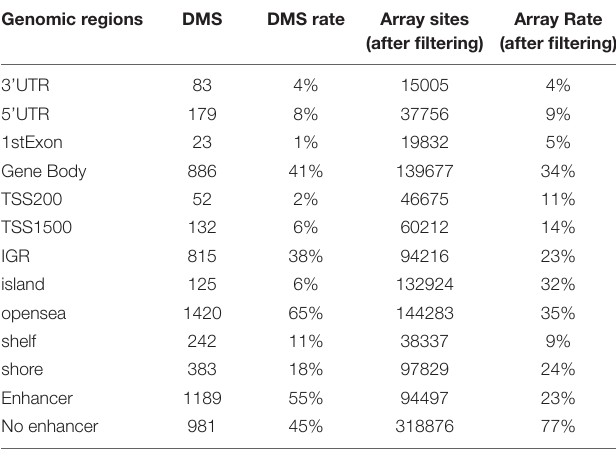
TABLE 2 | DMS and Array sites (after filtering) in different genomic regions. Genomic regions